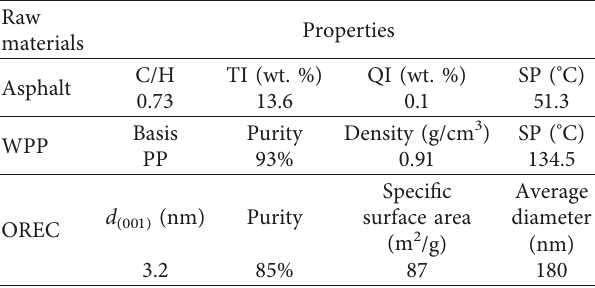
Table 1: The properties of petroleum pitch, WPP, and OREC.